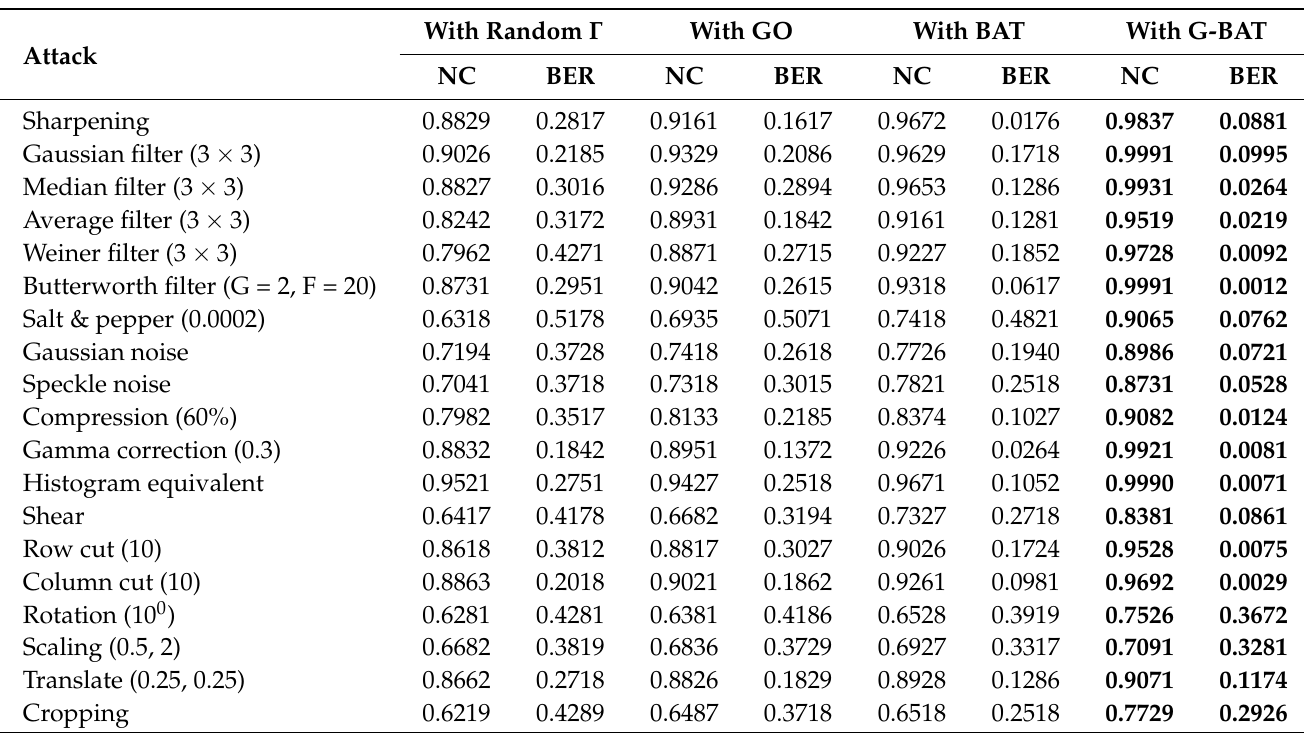
Table 6. NC and BER for Lena image under attacks with random Γ and with optimized Γ using GO, BAT and G-BAT.